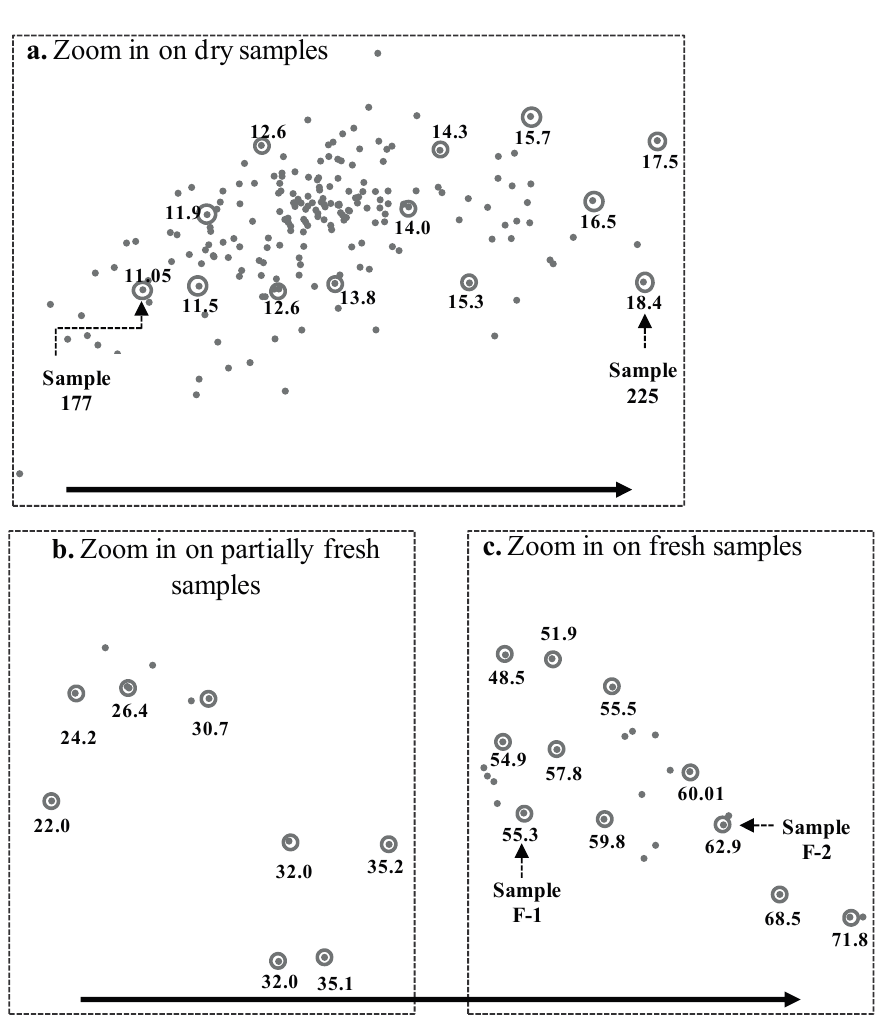
Figure 9. Result of uploading the total area absorption into the score plot of the partial least squares (PLS) model for crude protein (CP). Numbers next to gray circles represent the total area of water absorption. ( a ) Zoom in on dry samples, ( b ) Zoom in on partially fresh samples, ( c ) Zoom in on fresh